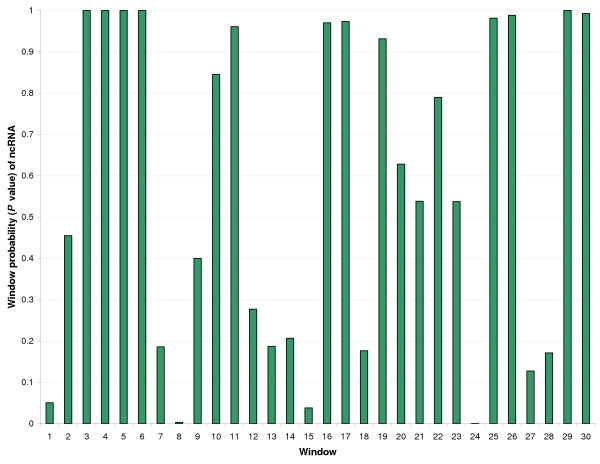
ncRNA probabilities (P values) of scanning windows iterating through a 16S rRNA. Probabilities of ncRNA computed by the Dynalign/LIBSVM classifier for 30 150-nucleotide-long scanning windows iterating through a global alignment of Borrelia burgdorferi and Bacillus subtilis 16S rRNA in steps of 75.